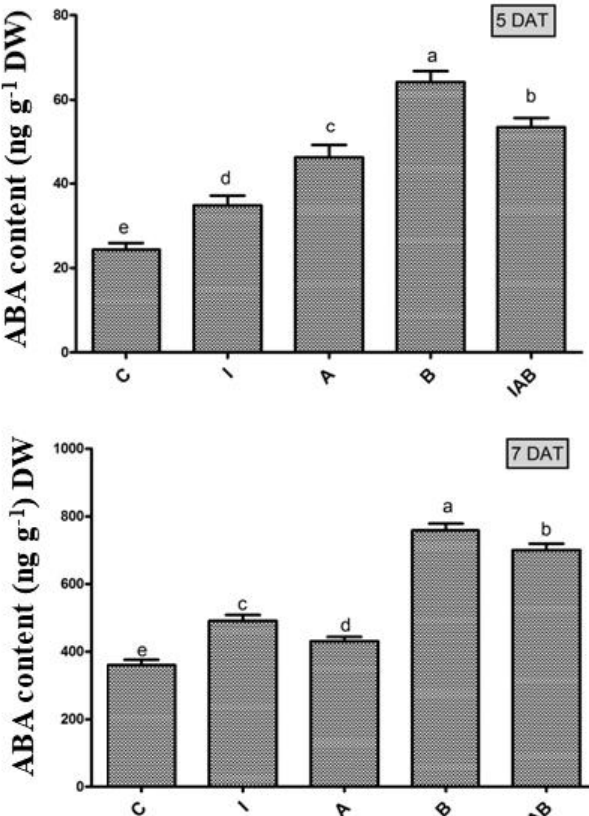
Figure 5. Effect of the YNA12 culture filtrate on the regulation of ABA in evening primrose seedlings: Data are presented as the mean ± standard deviation ( n = 3), and significant differences between the control and endophytic YNA12 treatments were analyzed with one-way ANOVA followed by Duncan’s multiple range test ( p < 0.05).